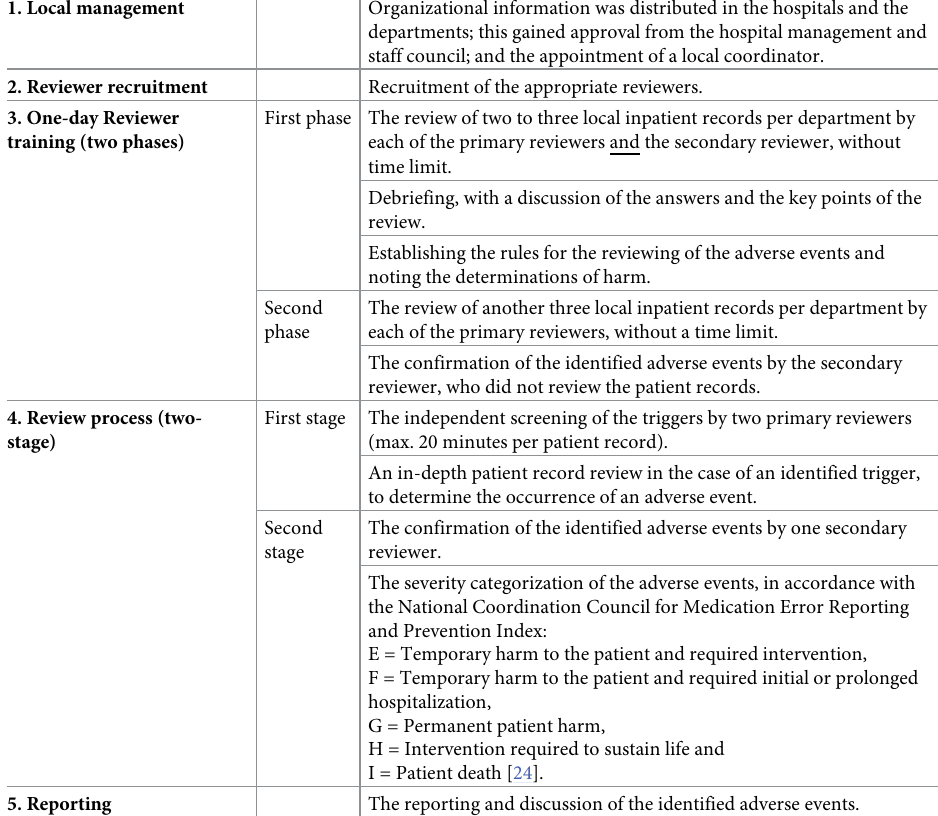
Table 1. Implementation process with the Global Trigger